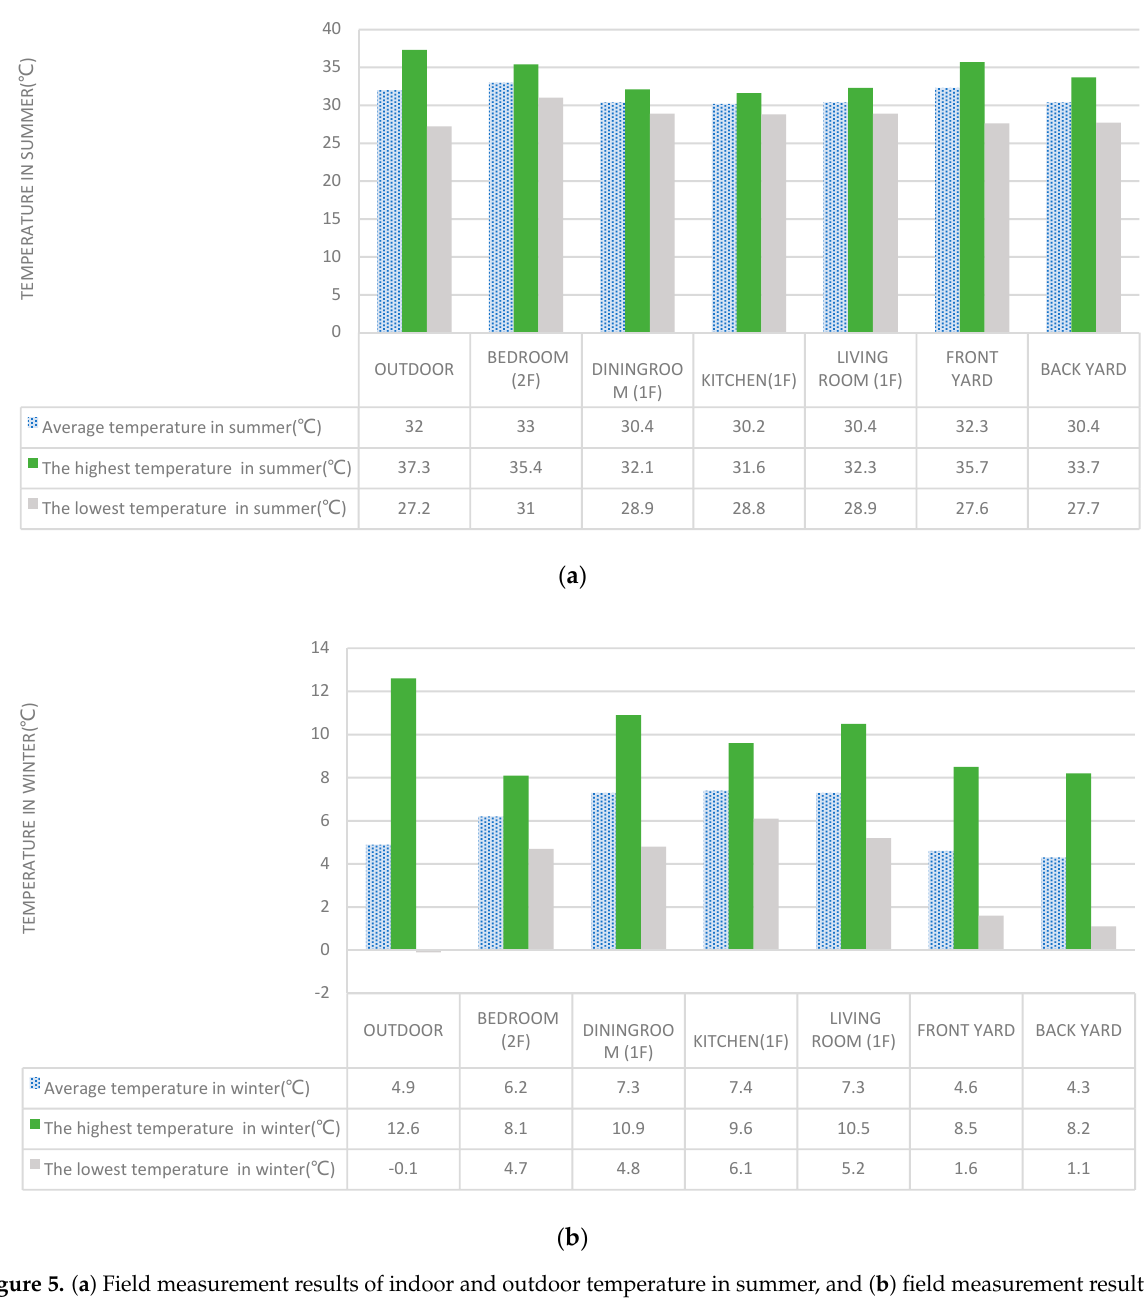
Figure 5. ( a ) Field measurement results of indoor and outdoor temperature in summer, and ( b ) field measurement results of indoor and outdoor temperature in summer and winter.